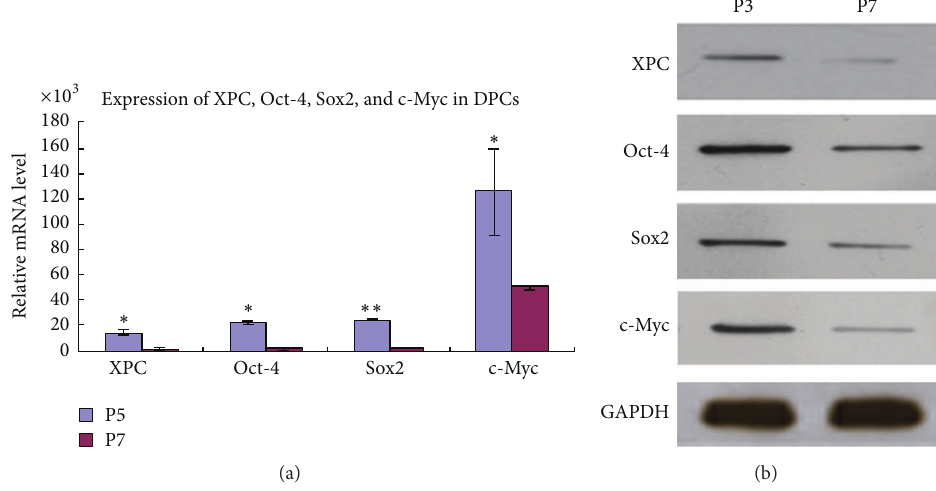
Figure 1: Expression of XPC, Oct-4 , Sox2, and c-Myc in DPCs at various passages. Real-time PCR showed that mRNA expression of XPC, Oct- 4 , Sox2, and c-Myc was significantly higher in DPCs at passage 3 compared with passage 7 (a) ( ∗ 𝑝 < 0.05 , ∗∗ 𝑝 < 0.001 ). Western blot showed that the protein expression of XPC, Oct-4, Sox2, and c-Myc revealed similar expression pattern with real-time PCR, which was stronger in DPCs at passage 3 compared with passage 7